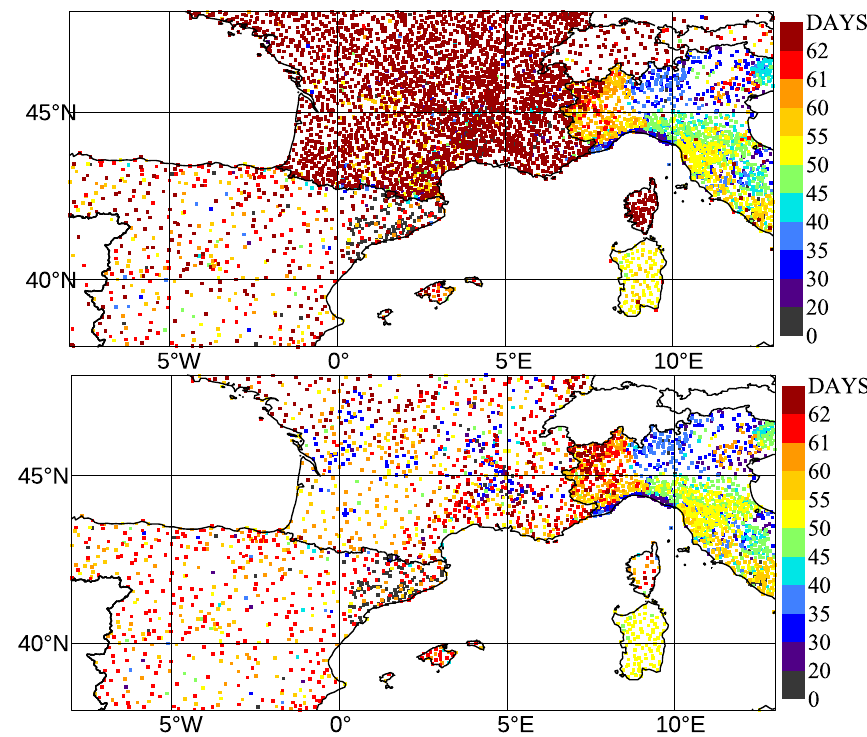
Figure 10. Number of available 24h accumulated precipitation observations from 06:00 to 06:00UTC the next day (top) and from 00:00 to 00:00UTC the next day (bottom) for the period ranging from 05 September to 05 November 2012 (62 days) in the HyMeX database on 01 January